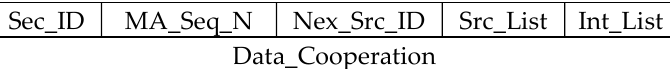
Figure 5. Mobile agent form.